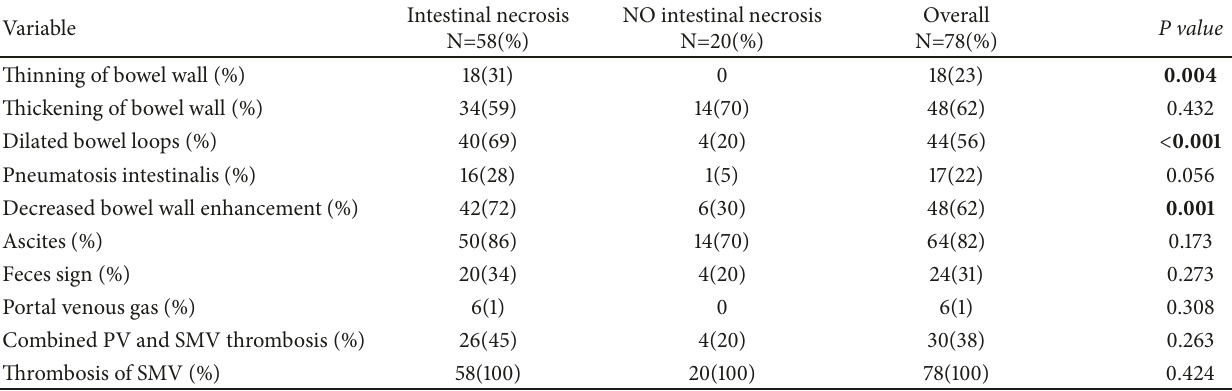
Table 2: Univariate analysis for computed tomography finding of mesenteric vascular thrombosis in 78 patients. Variable